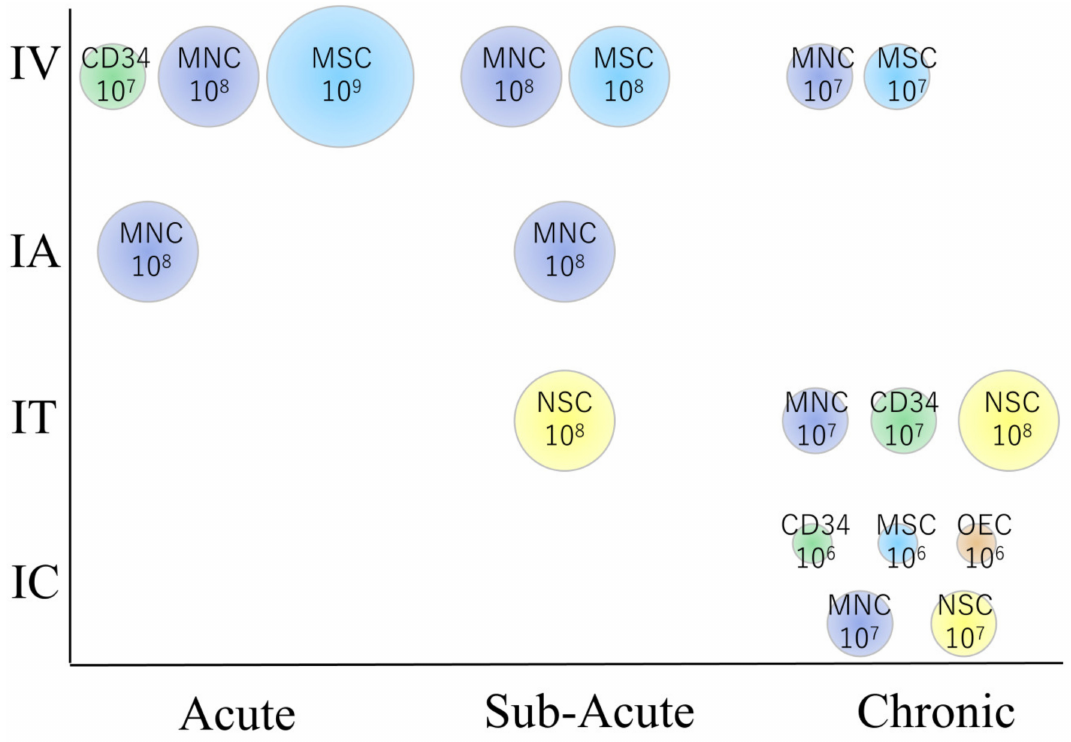
Figure 2. The relationship between cell types, dose, and patient characteristics in clinical trials. Note that intravenous transplantation is preferred in the acute phase, while intracerebral transplantation is preferred in the chronic phase. MNC: CD34: CD34 positive hematopoietic stem cells derived from mononuclear cells, MSC: Mesenchymal stem / stromal cell, NSC: Neural stem / progenitor cell, OEC: Olfactory ensheathing cell. The number represents the approximate amount of cells transplanted per patient (cells /